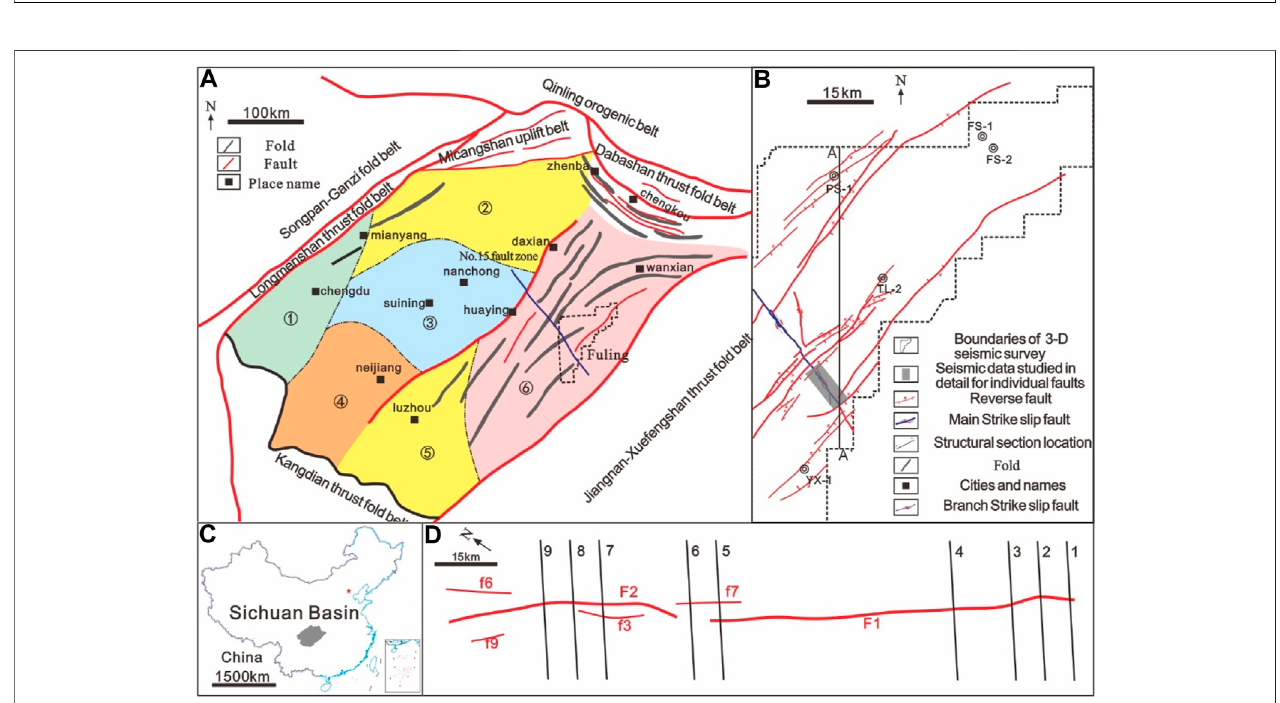
FIGURE 3 | (A) Simpli fi ed tectonic map showing the major tectonic units and fault distributions in Sichuan Basin, this basin covers an area of 26 × 10 4 km 2 , ① : Chuanxi depression ② : Chuanbei Composite highly steep folded structural belt, ③ : Chuanzhong uplift, ④ : Chuanxinan fold structural belt ⑤ : Chuannan fold structural belt, ⑥ : Chuandong highly steep folded structural belt. (B) Fault distribution map of Fuling work area. (C) The location of the Sichuan Basin on a map of China. (D) Fault distribution map of the South No. 15 Strike-slip Fault Zone.